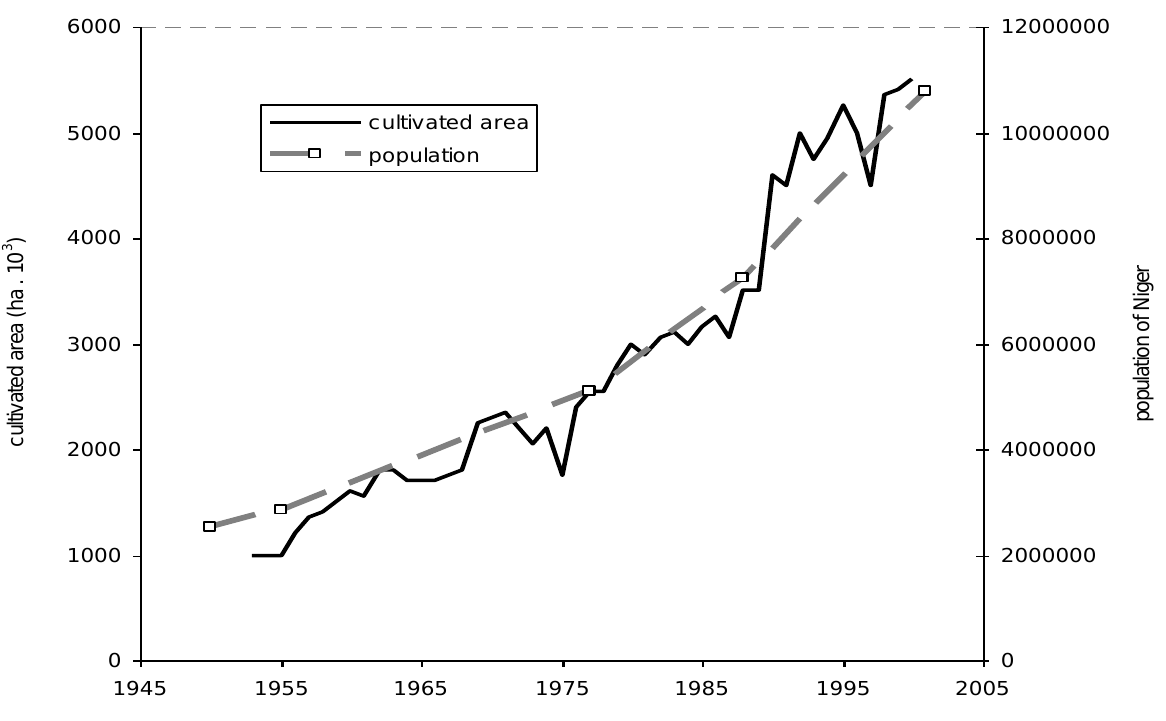
Figure 10. Evolution of crop areas in the Niger since